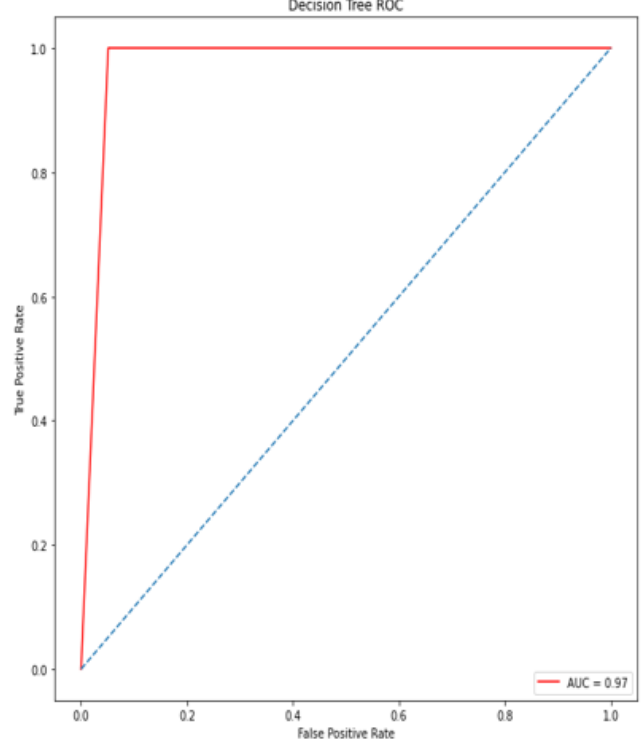
Figure 13. ROC/AUC of Logistic Regression.